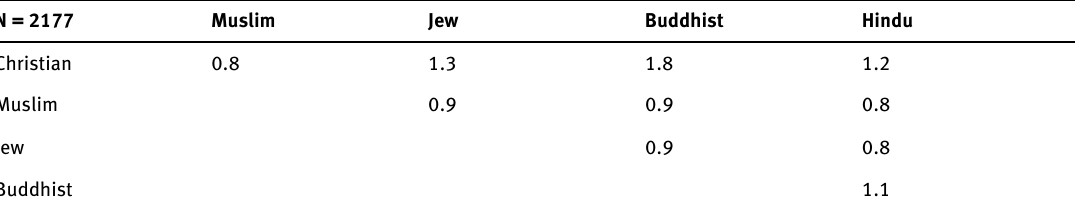
Table 2. Combination of self-identifications in the emic approach in % of the